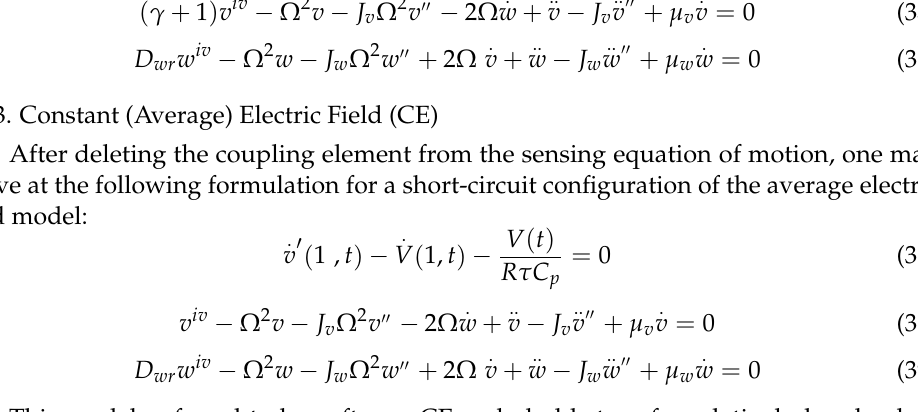
Table 1. Summary of models. Voltage Model Representation Spatially varying electric field